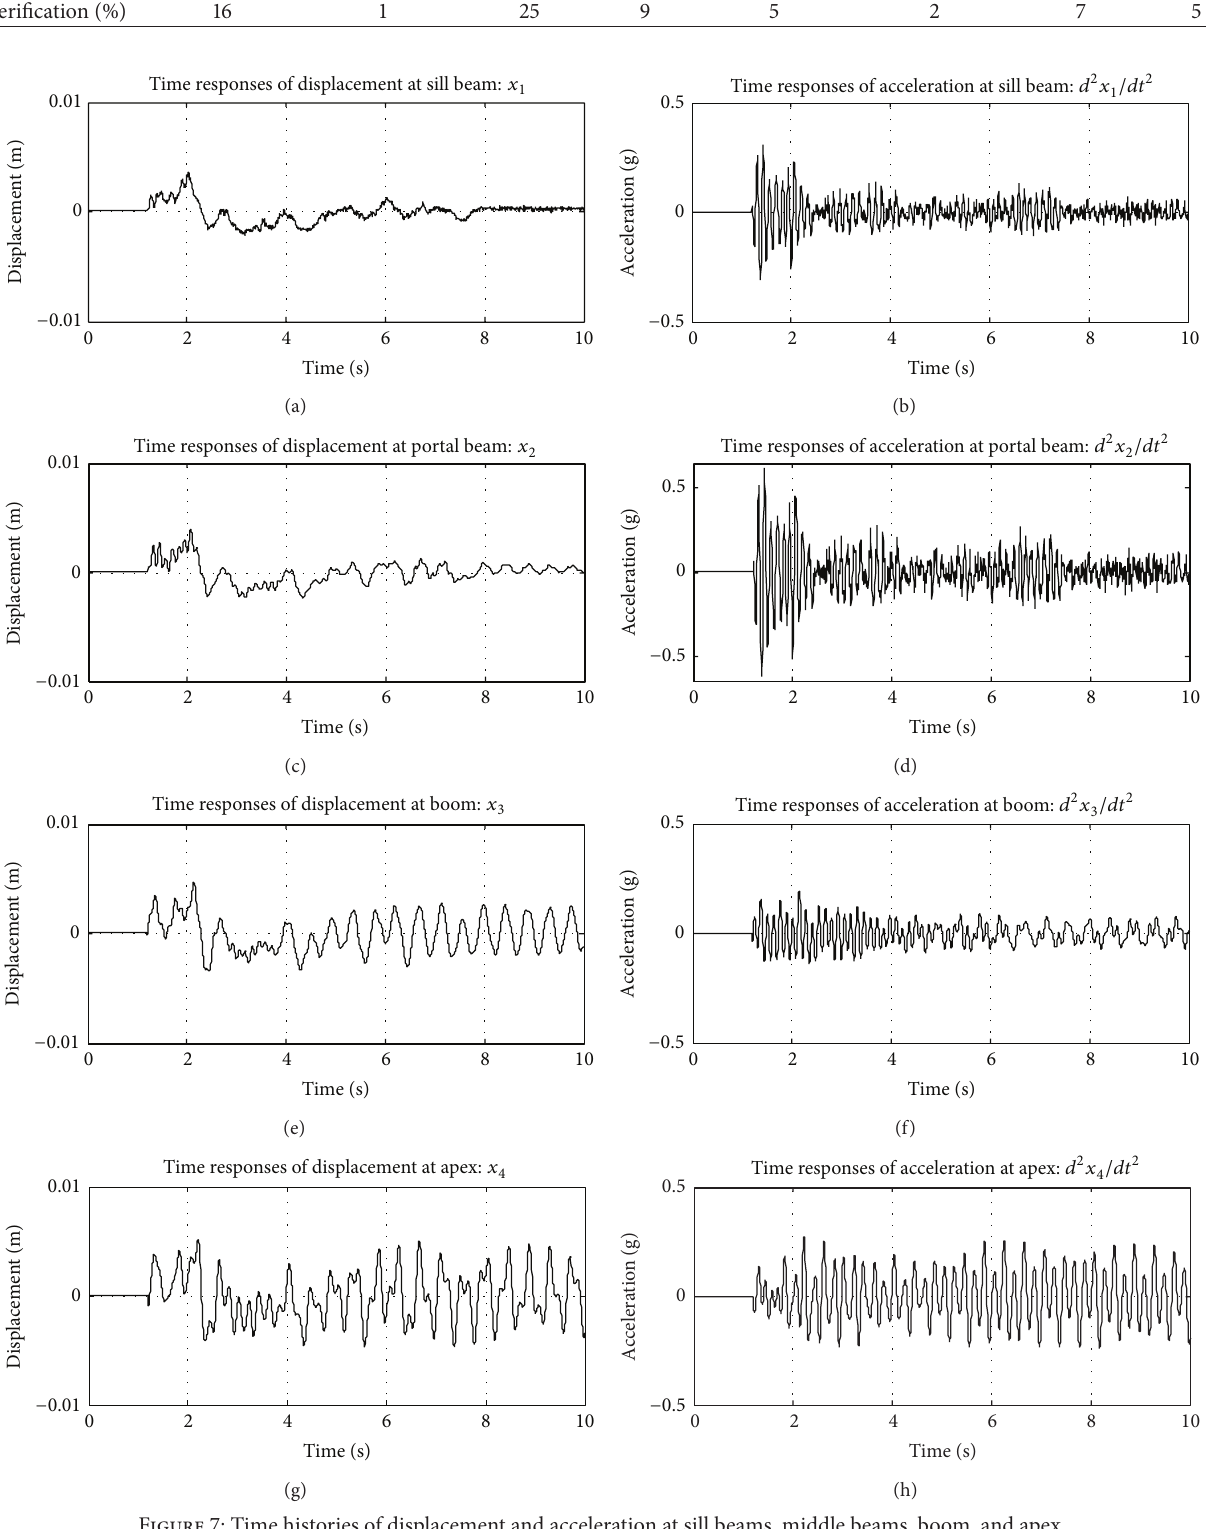
Figure 7: Time histories of displacement and acceleration at sill beams, middle beams, boom, and